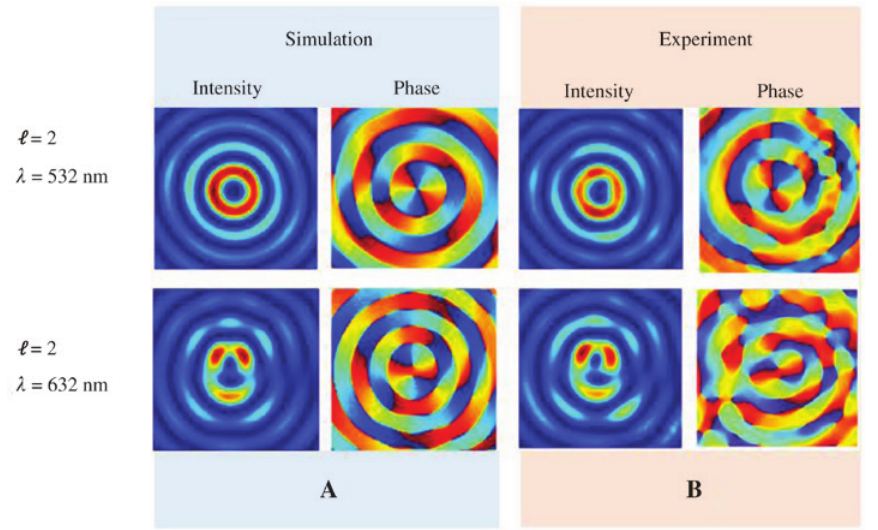
Figure 4: Simulations and experimental results of anomalous Bessel vortex beams with different wavelengths at same propagation distance. (A) Simulations; (B) experimental